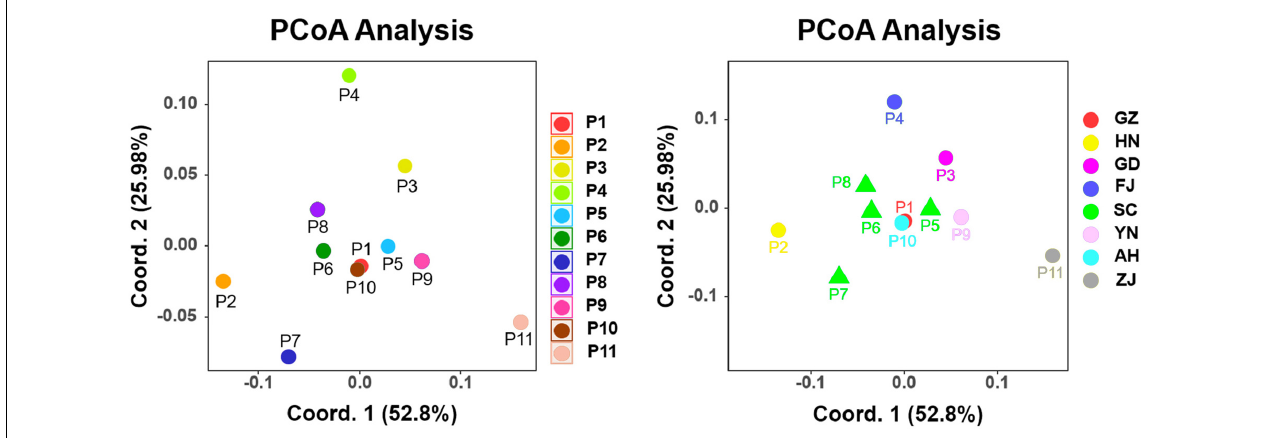
FIGURE 2 | Two-dimensional plot of the principal coordinates analysis of the 11 populations ( left ) and eight provincial groups ( right ).